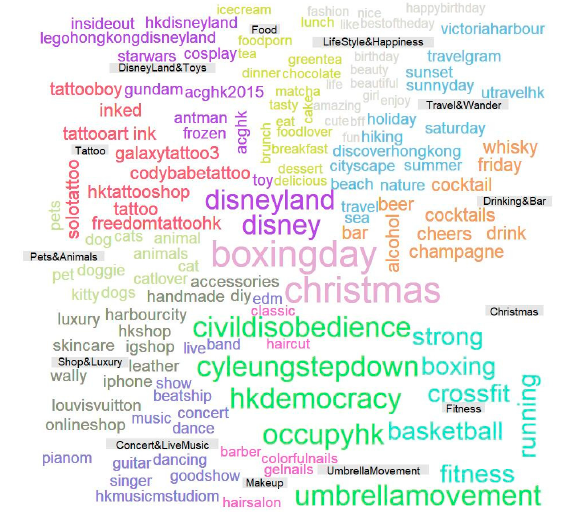
Figure 12. A comparative word cloud of 13 hashtag communities.